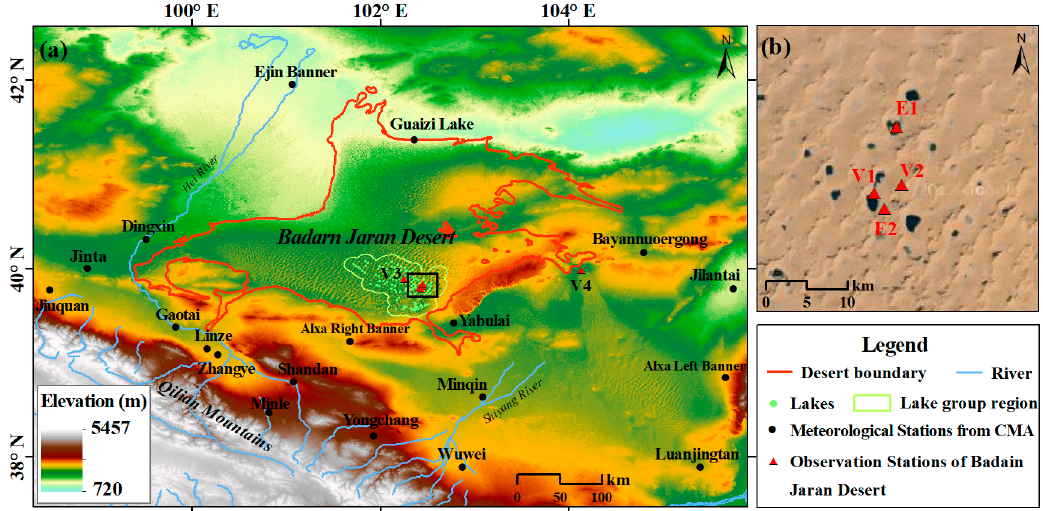
Figure 1. Data collection stations: ( a ) the distribution of meteorological stations in the BJD and ( b ) observation stations in the lake group area.